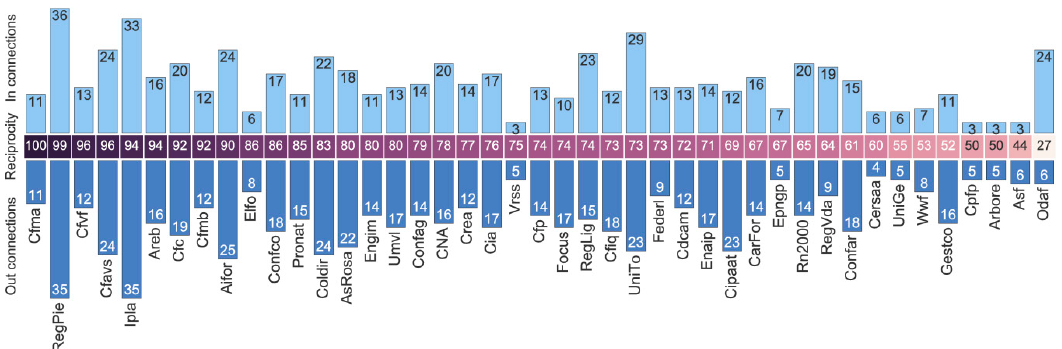
Figure 1. Similarity analysis among incoming and outgoing links.